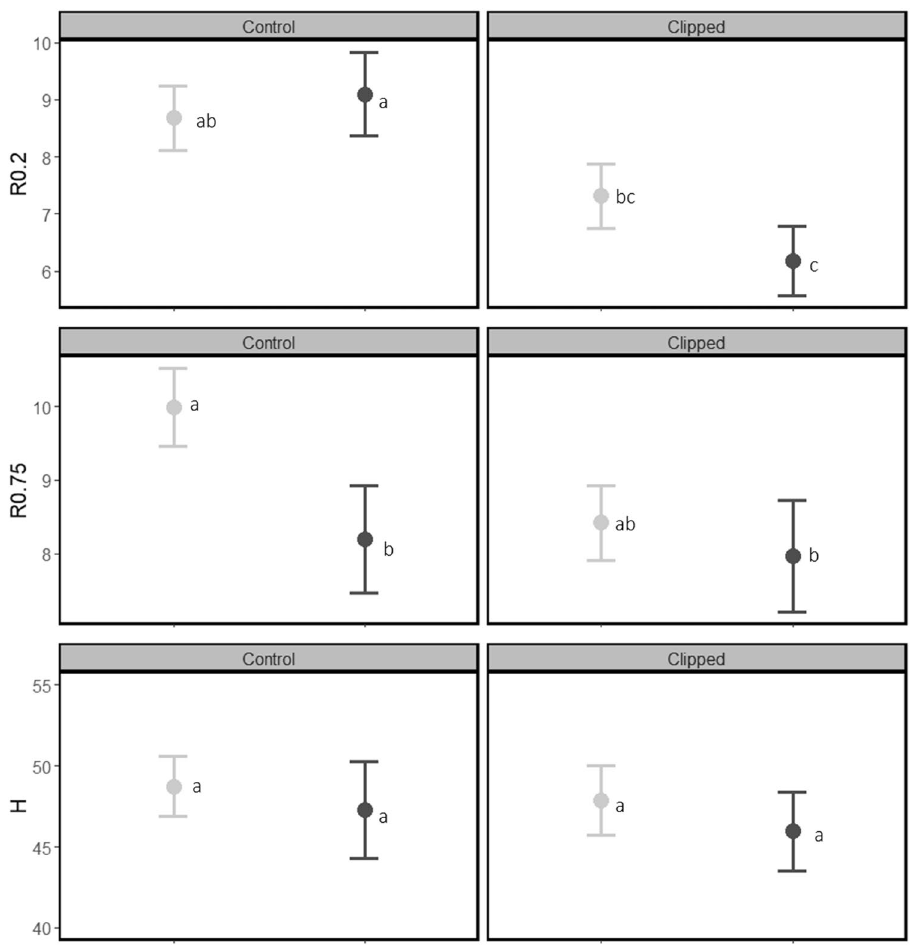
Figure 1. Total growth increment of pine trees in 2016 (mean ± SEM) at 0.2 m stem height (R0.2), 0.75 m stem height (R0.75) and in height (H). Vertical panels represent the browsing treatments: control (un-clipped) and clipped. Colours represent the sawfly treatments: no sawflies (light grey markers and error bars) or sawflies (dark green markers and error bars). Letters denote significant differences between individual treatments. Mean growth (left to right, top to bottom): 8.68, 9.10, 7.32, 6.18, 9.99, 8.19, 8.42, 7.96 mm and, 48.7, 47.3, 47.8, 46.0 cm.